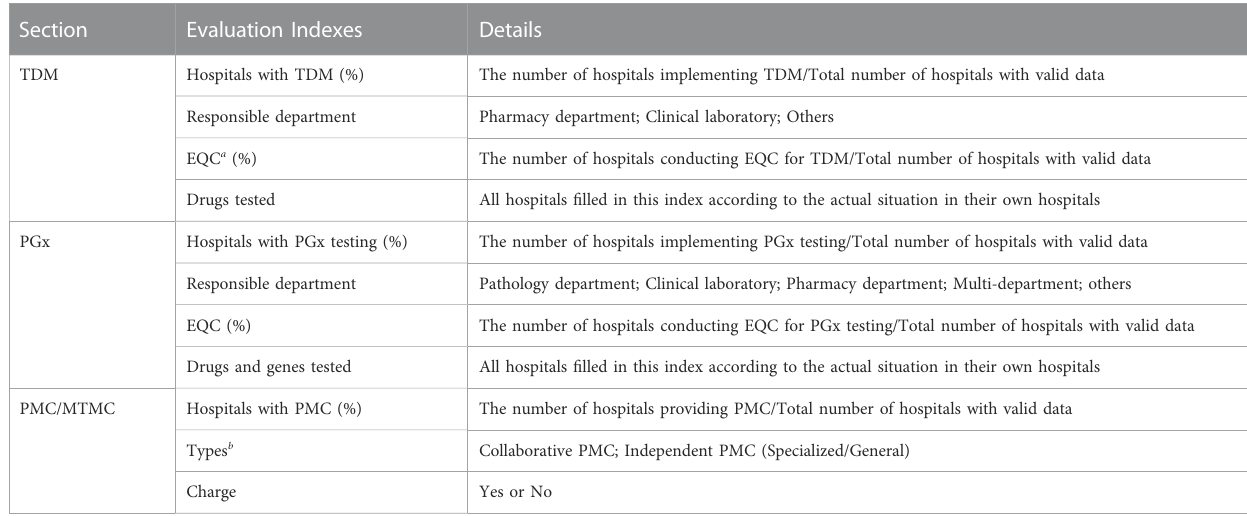
TABLE 1 Indexes analyzed in our survey.